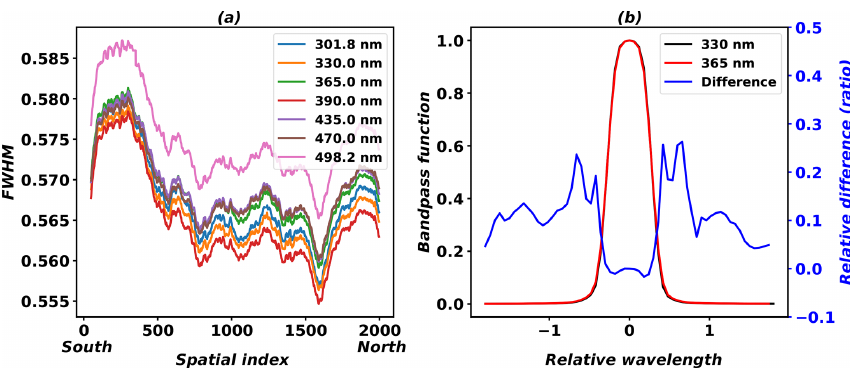
Figure 3. Full width at half maximum (FWHM) of GEMS bandpass as a function of spatial index of GEMS detection rows (a) and averaged bandpass functions for spatial indices at 330 and 365nm and relative differences (b)